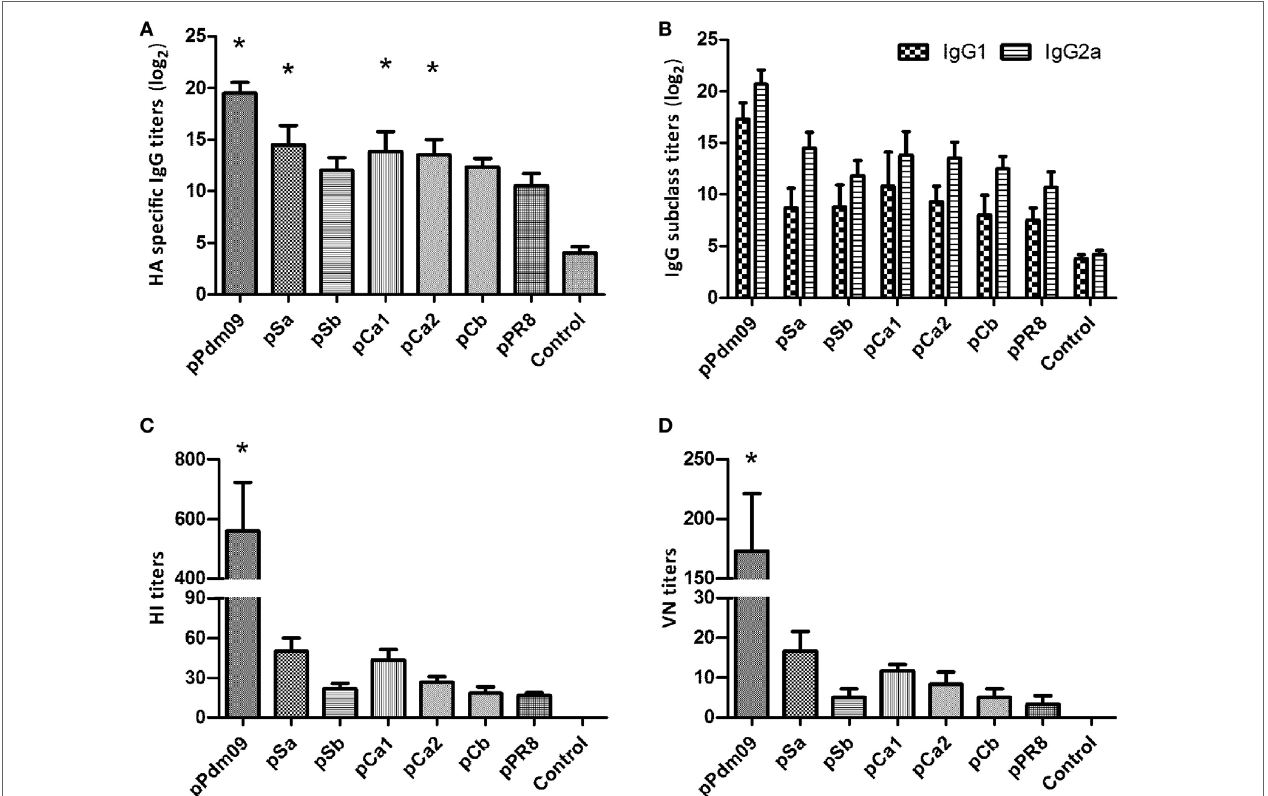
FigUre 3 | Antibody responses in mice immunized with plasmid DNAs substituted with one epitope of the Pdm09 HA. Female BALB/c mice (6–8 weeks old) were immunized twice, at an interval of 3 weeks, with 30 µg of plasmid DNAs substituted with one epitope of the Pdm09 HA. Thirteen days after the boost, the sera were collected for Ab analyses: (a) for immunoglobulin G (IgG); (B) for IgG subclass; (c) for hemagglutination-inhibition assay; and (D) for VN assay. Bars and whiskers represent the average and SD. Asterisk symbol (*) indicates a significant difference compared with pPR8 ( p <